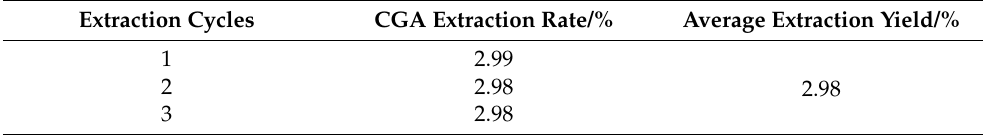
Table 6. Validation fitting results under optimal process